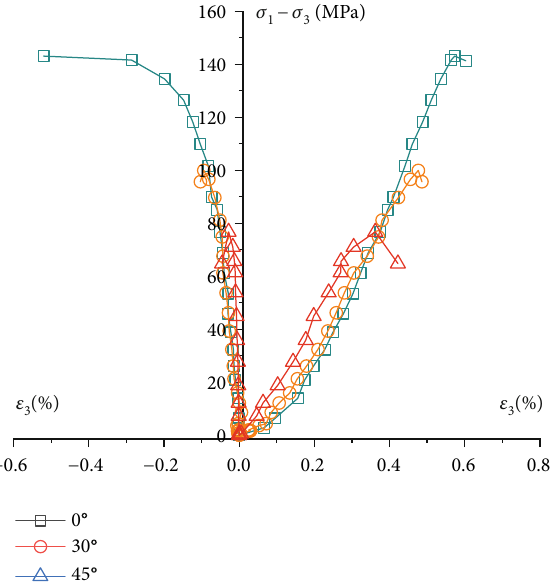
Figure 7: Stress-strain curves of fi ssured granites with α = 0 ° , 30 ° , and 45 ° under the uniaxial compression test without chemical corrosion.